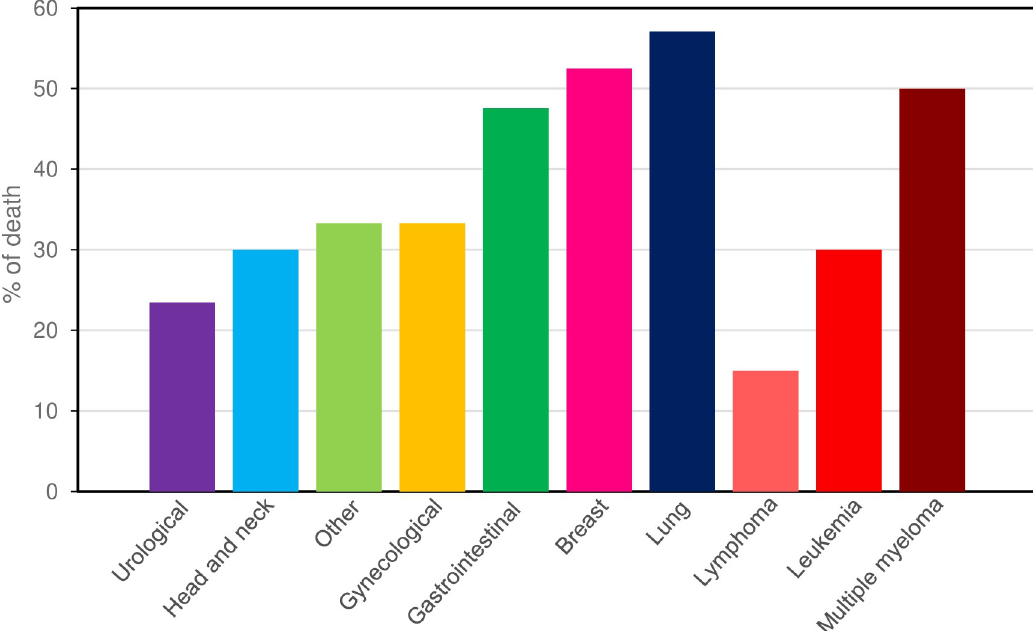
Fig 2. COVID-19-related mortality rate according to the cancer type.